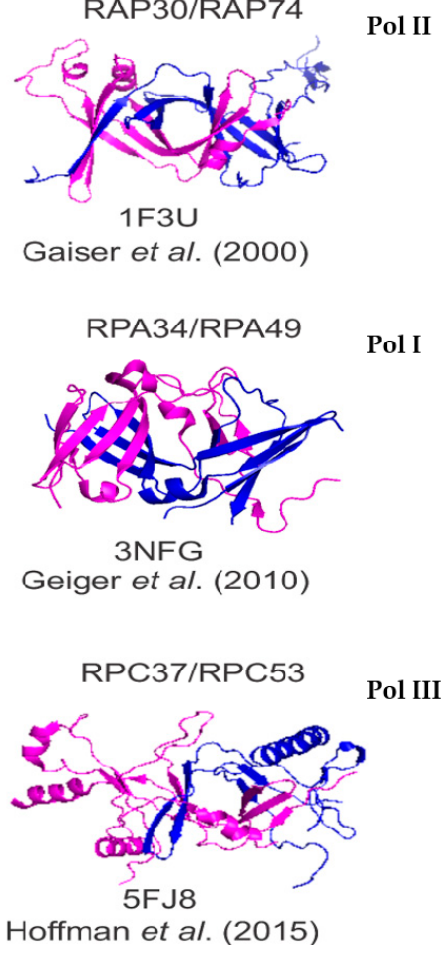
Figure 3. Structural similarities of the dimerization modules of the homologous subunits of Pol II (RAP30/74), Pol I (A49/A34), and Pol III (RPC37/53) [24–26].